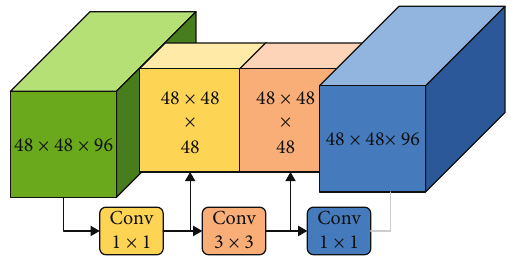
Figure 1: Structure of the